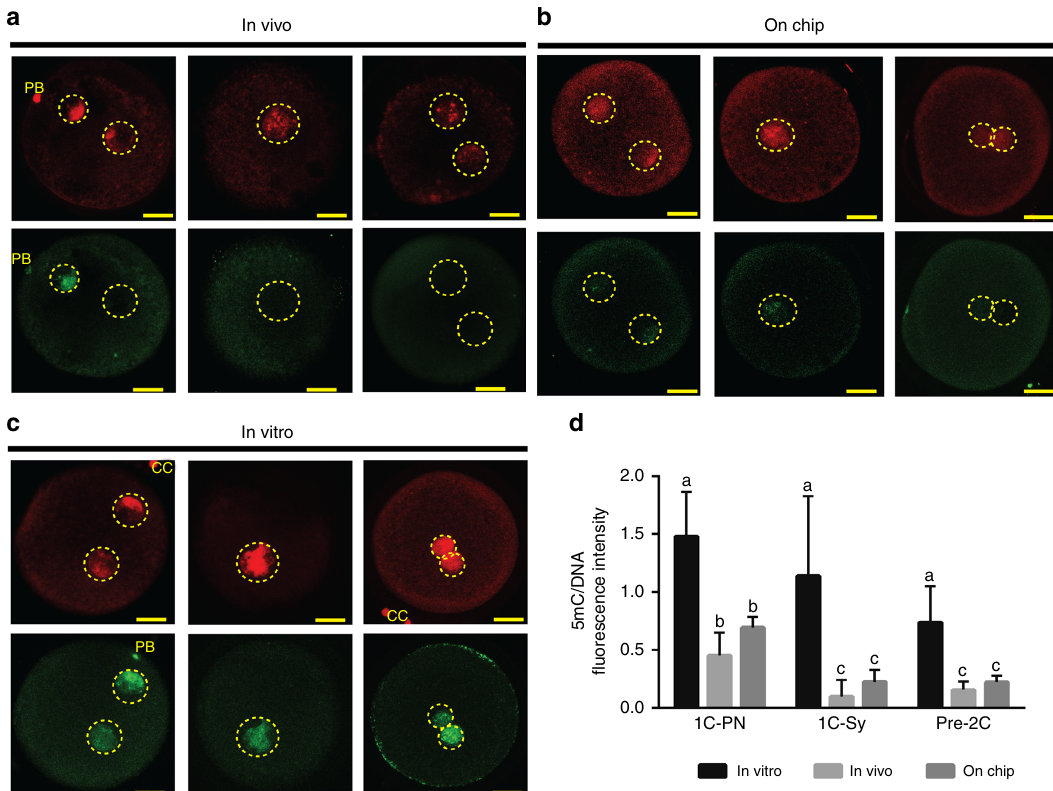
Fig. 6 In vivo ( a ), on chip ( b ), and in vitro ( c ) zygotes; indirect immuno fl uorescent staining for global methylation (5mC, green) and DNA (propidium iodide, red) in the pronuclei. d Quanti fi cation of 5mC staining in zygotes, 5mC fl uorescence intensity was normalized using total DNA fl uorescence ( n = 30 for in vivo, n = 30 for in vitro and n = 30 for on chip zygotes; F = 7.458, p = 0.011; ANOVA followed by a post-hoc Tukey test). Graph of d display average + s.d. Negative controls omitting primary antibody were used and no fl uorescence was observed. Different letters (a vs b vs c in d ) indicate statistical differences between the groups ( p < 0.05). Scale bars = 25